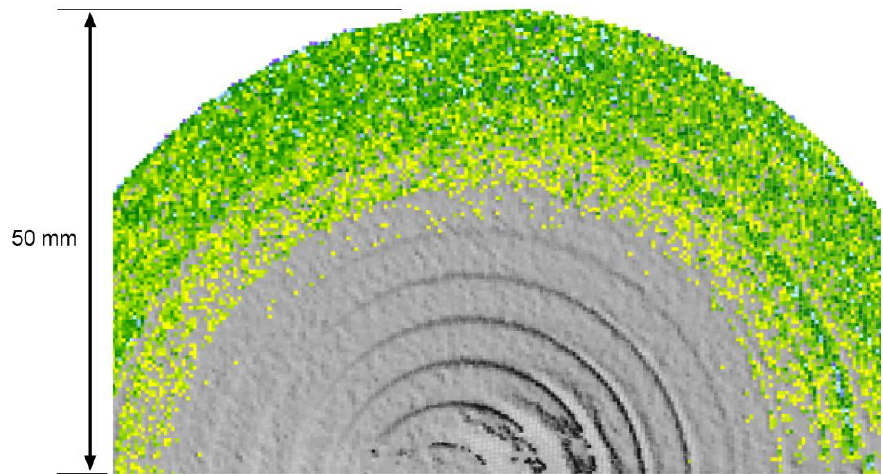
Figure 8. Color coded deviation of the range map originated by the acquisition of the set-of-steps with a Minolta Vi with 14 mm lens respect to the reference plane obtained by best-fitting the first plane (zero reference). It appears clear that with this scanner the first two steps are not